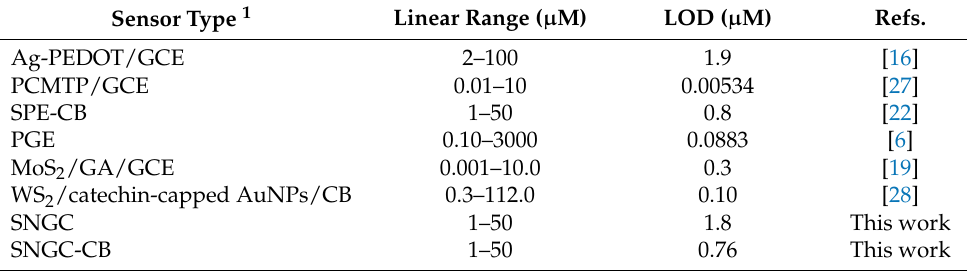
Table 1. Comparison of the analytical performances of the SNGC-CB sensor with those of other electrochemical sensors reported in the literature.